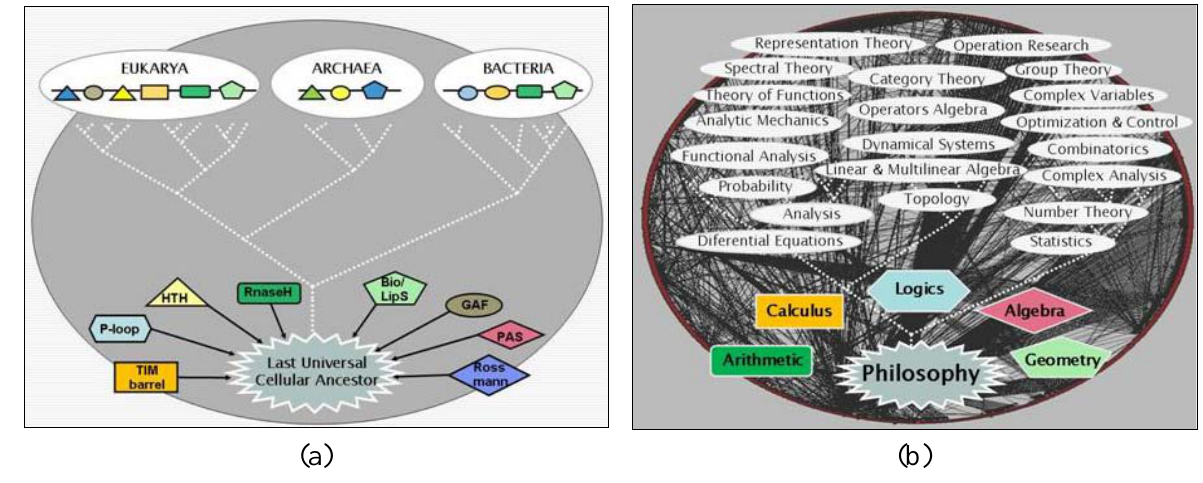
Figure 4. Parallel between recombination events in the evolution of the protein universe and in the evolution of the sciences. ( a ) The “big bang” of protein